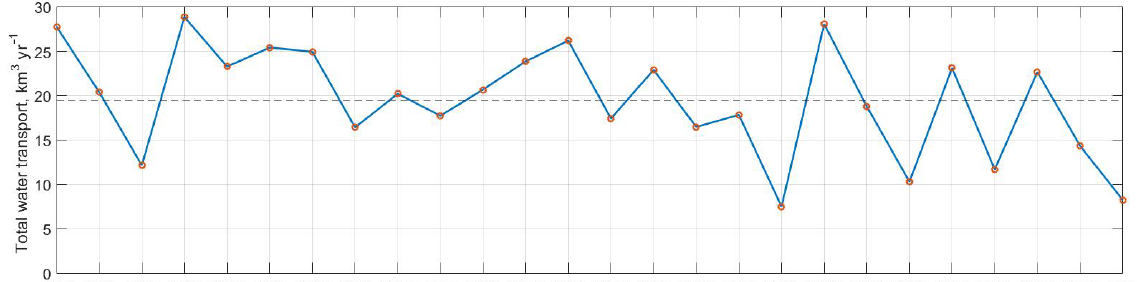
Figure 4. Yearly mean values of total water transport through the Kerch Strait in km 3 yr − 1 . Dashed line: average yearly transport over the entire period of the experiment.